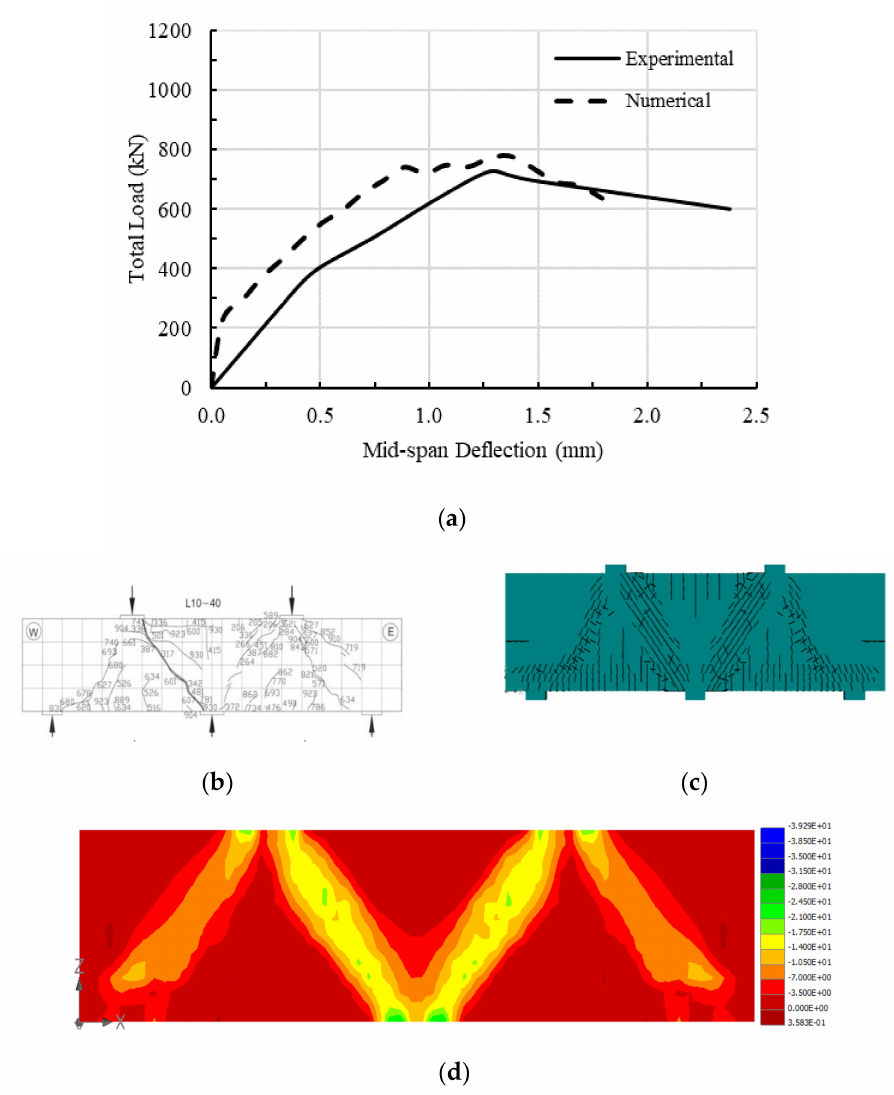
Figure 6. Experimental and numerical responses of specimen L10-40 (RHR supports) : ( a ) Experimental [9] and numerical load-deflection curves for specimen L10-40; ( b ) experimental crack pattern [9]; ( c ) numerical crack pattern; ( d ) stress distribution